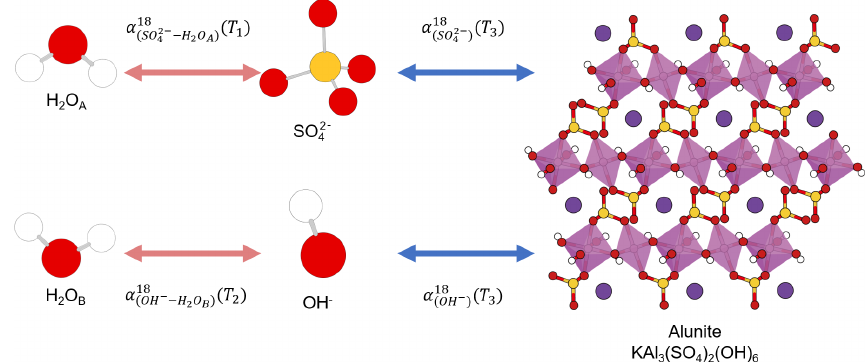
Figure 1. Sketch of alunite precipitation from water. The alunite could be a single-mineral geothermometer if three conditions are all fully satisfied: (1) H 2 O A = H 2 O B , (2) T 1 = T 2 = T 3 , and (3) all the four reactions are fully reversible and attain equilibrium. White, red, yellow, pink, and purple spheres represent hydrogen, oxygen, sulfur, aluminum, and potassium atoms, respectively.